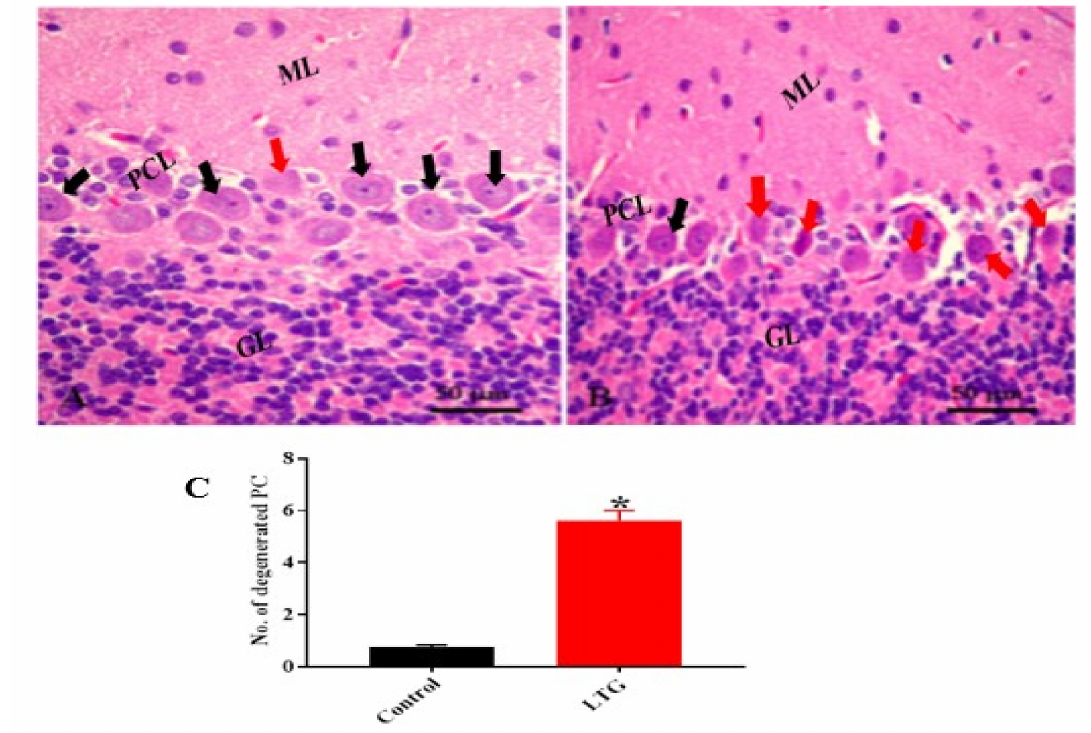
Figure 7. ( A ) Photomicrograph of control cerebellar cortex showing the layers of the cerebellum: The molecular layer (ML), the middle Purkinje cell layer (PCL) with a large pyriform shape (black arrow), and the inner granular layer (GL) with aggregation of granular cells. ( B ) Lead-treated group (LTG) showing marked degeneration of Purkinje cells (red arrow). ( C ) Semi-quantitative representation of degenerated Purkinje cells of the control group and LTG. Data are represented as mean ± SEM ( n = 3); * p < 0.05 vs. control. H and E 400 × , scale bar = 50 µ m. Cerebellum Stained with Toluidine Blue In order to further confirm the neurodegenerative e ff ect of Pb acetate induction on the cerebellums of rats, toluidine blue staining was also performed. The histological results from the cerebellums of rats in the LTG indicated degeneration of the cells of the molecular layer and distortion of the Purkinje cell layer, with the Purkinje cells having a darkly stained cytoplasm and distorted nuclei with empty space between them, indicating loss of Purkinje cells (Figure 8B) compared with rats in the control group (Figure